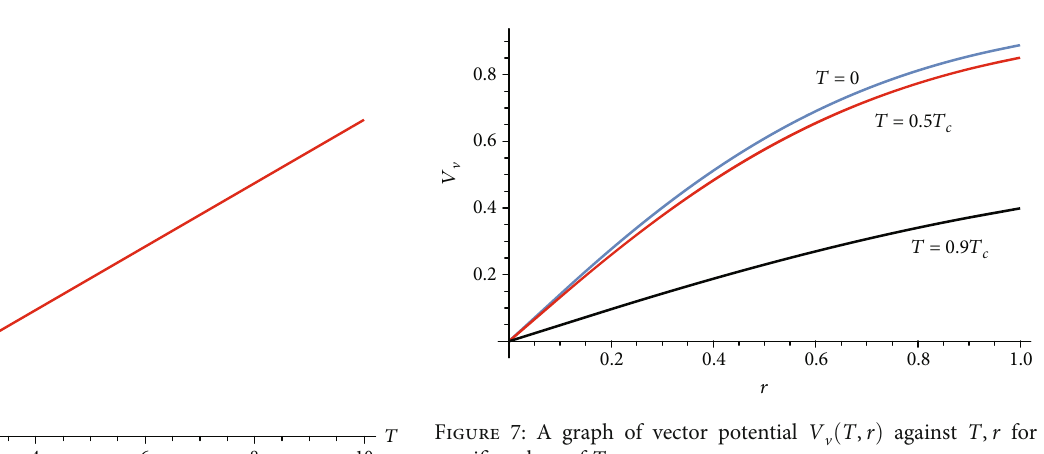
for di ff erent values of m c 2